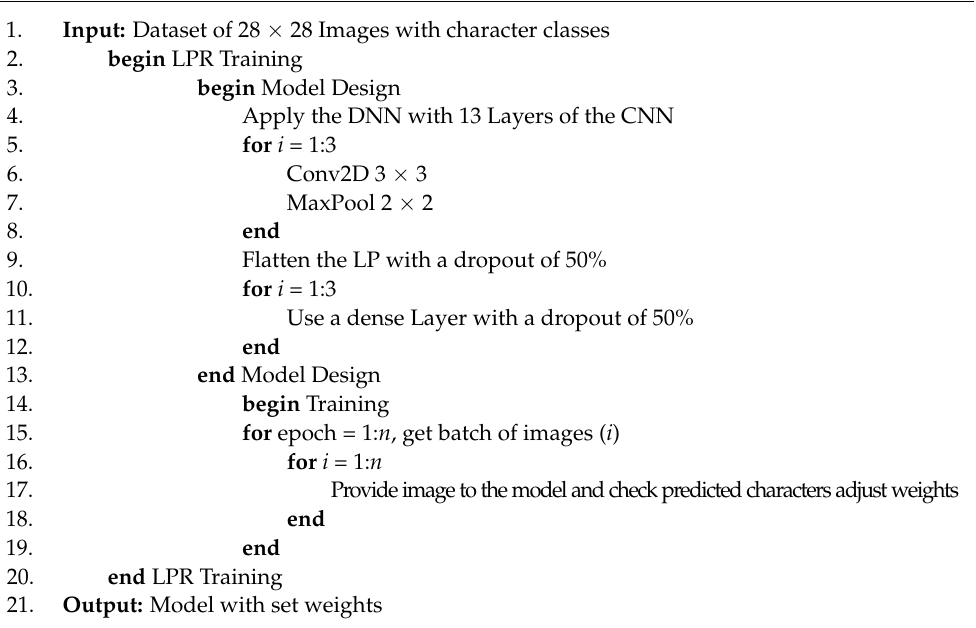
Algorithm 5: The LPR model